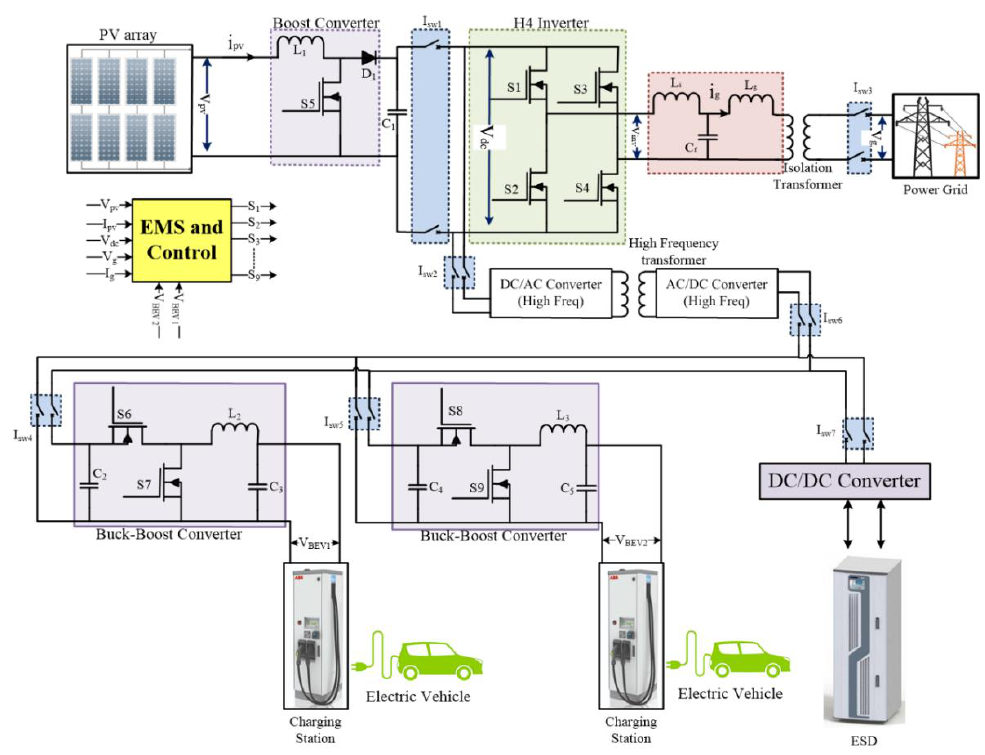
Figure 7. Simulink implementation of grid-connected PV–EV (GCPE) charging architecture with energy storage device (ESD) and intelligent energy management system (iEMS).